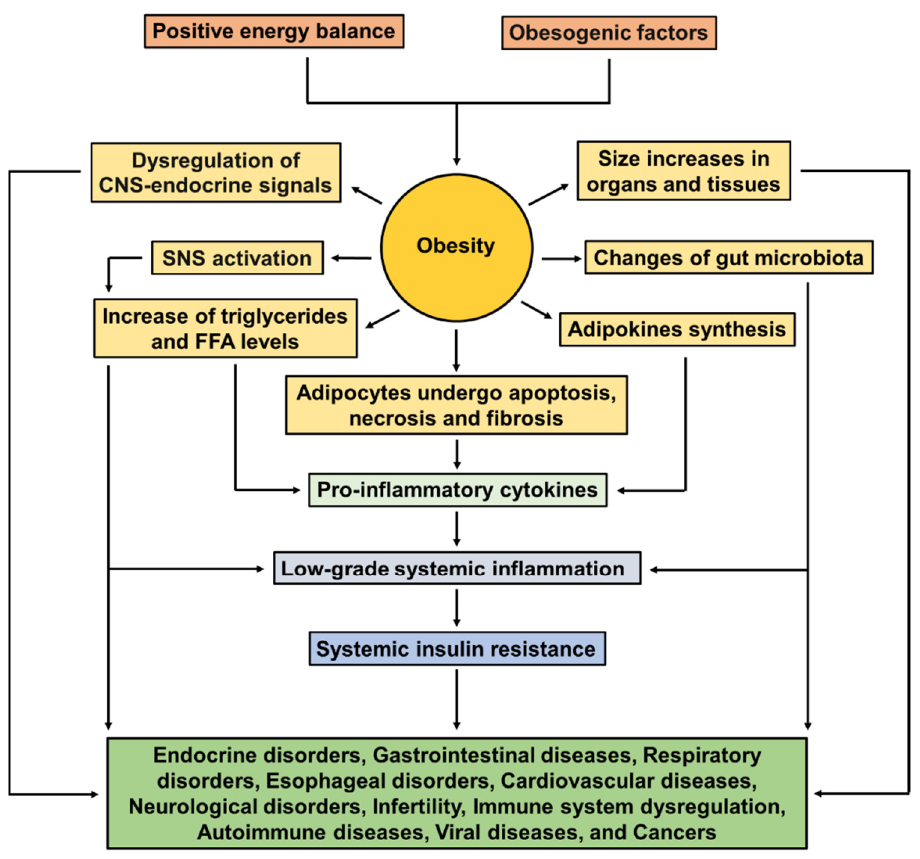
Figure 1. Pathophysiology mechanisms of obesity. Excess of energy-dense foods along with obe- sogenic factors induce obesity, which may cause several different disorders and diseases. Abbreviations: CNS, central nervous system; SNS, sympathetic nervous system; FFA, free fatty acid.